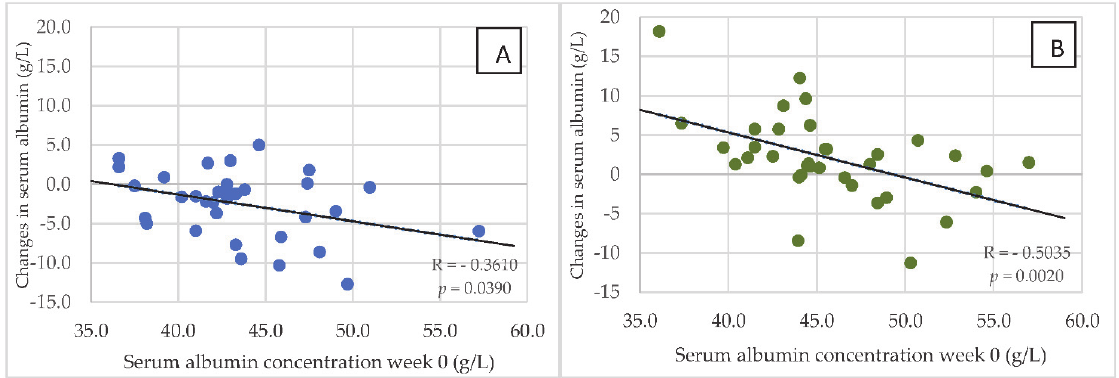
Figure 5. ( A , B ) Relationship between the serum concentration of albumin at baseline (in week 0) and changes in this parameter after 24 weeks of the nutritional intervention in HG1 ( A ) and HG2 ( B ). Abbreviations as in Figure